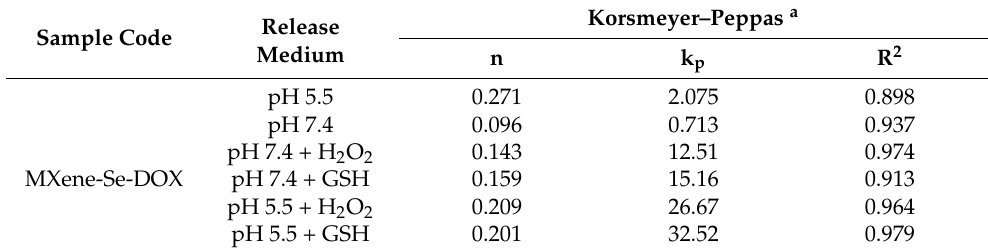
Table 2. In vitro DOX release mechanism analysis based on the Korsmeyer–Peppas